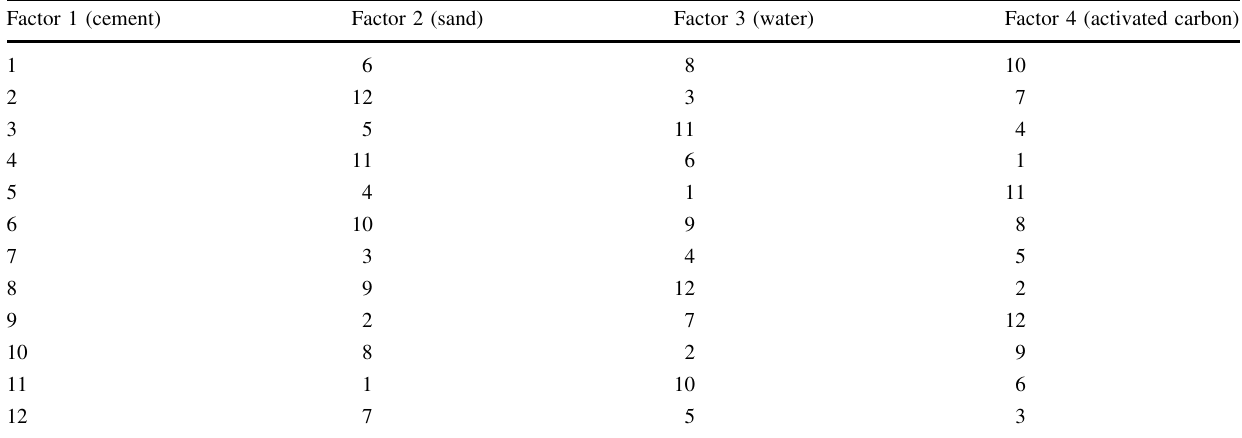
Fig. 3 Compositions of coal-like materials Table 2 Uniform design table of 5 factors and 12 levels Factor 1 (cement) Factor 2